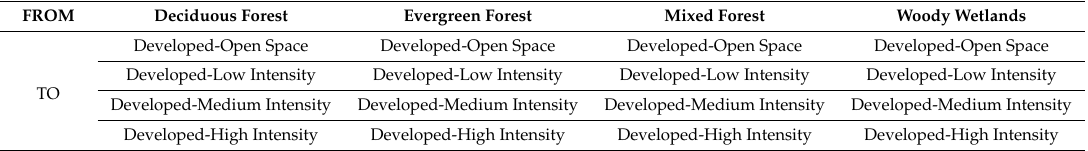
Table 1. Classes used derived from NLCD Change Product (2001 to 2011) to derive an error matrix. FROM Deciduous Forest Evergreen Forest Mixed Forest Woody Wetlands Developed-Open O T TO